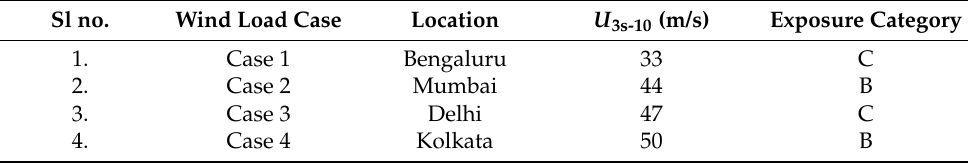
Table 3. General characteristics of site-specific wind load cases considered in the current study. Sl